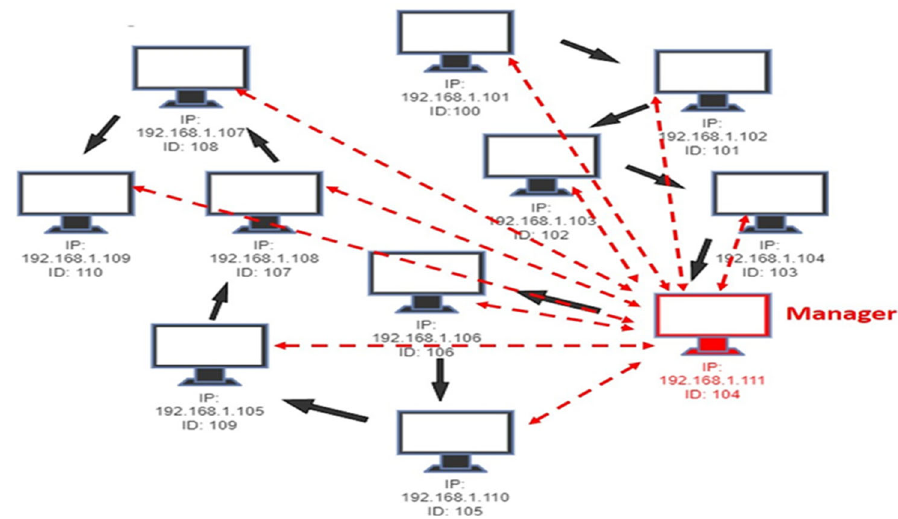
Figure 7. Network structure showing the selected manager.